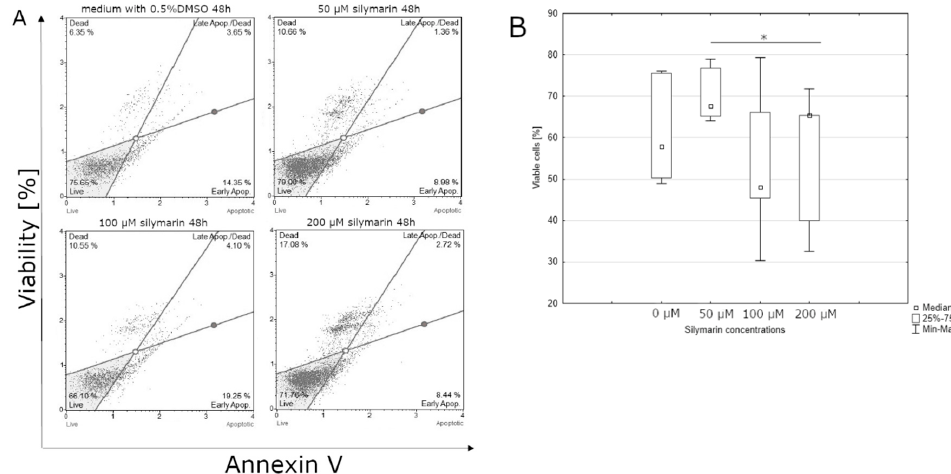
Figure 4. ( A ) silymarin induces apoptosis in the U-118MG cells. Cells were treated with DMSO or various concentration of silymarin for 48 h. Adherent cells were collected and stained with Annexin V and 7-AAD and events for live cells were counted with the Muse Cell Analyzer; ( B ) e ff ect of the indicated concentrations of silymarin on U-118MG living cells after 48 h incubation using Annexin V staining. The representative experiment is a median and a di ff erence between silymarin concentration and the control evaluated using ANOVA Friedman p = 0.04 and post-hoc tests * p <